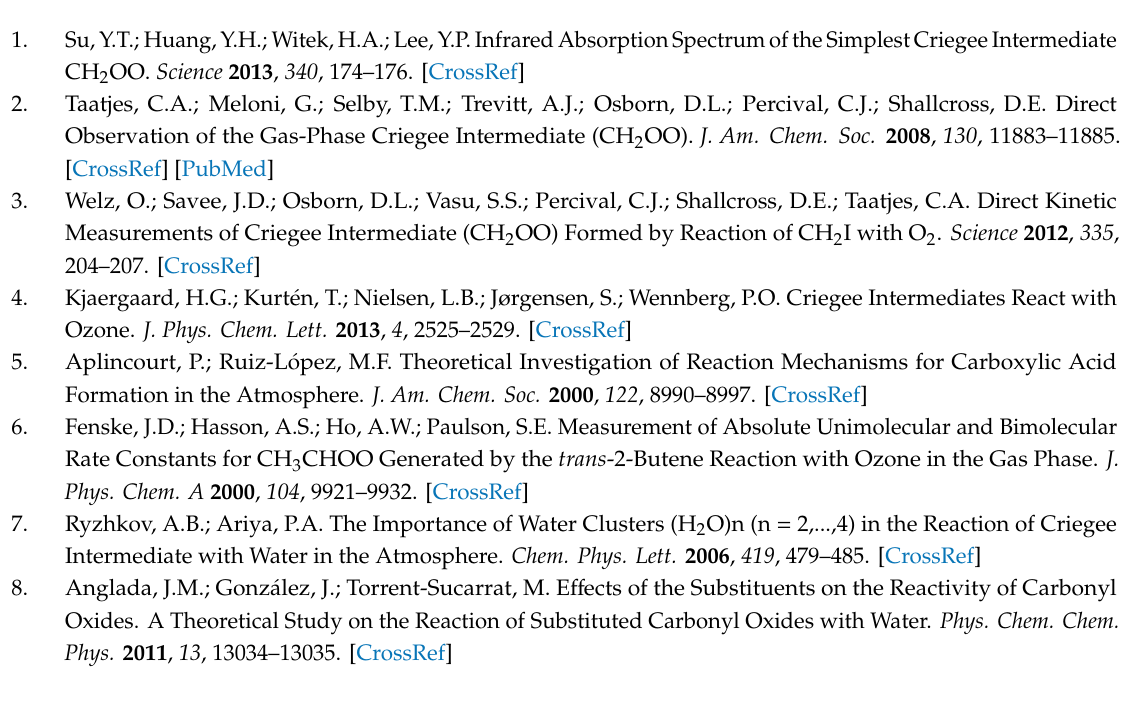
Supplementary Materials: Figure S1: Optimized geometries of species including reactants, reactant complexes, transition states and intermediates involved in the reaction of anti -PhCHOO + SO 2 at the UB3LYP / 6-311 ++ G(d,p) level. Figure S2: Optimized geometries of various species involved in the subsequent reaction pathways of IM1 at the UB3LYP / 6-311 ++ G(d,p) level. Figure S3: Optimized geometries of various species involved in the subsequent reaction pathways of IM2 at the UB3LYP / 6-311 ++ G(d,p) level. Figure S4: The intrinsic reaction coordinate of TSIM1-P3. Table S1: The total energies (hartree) obtained at the UCCSD(T) // UB3LYP and UCCSD // UB3LYP levels of theory together with the %TAE(T) of various species in the reaction of anti -PhCHOO + SO 2 . Table S2: The ZPE (hartree), total energies (E, hartree) and relative energies ( ∆ E, ∆ (E + ZPE), kJ / mol) without and with ZPE corrections of various species calculated at the UCCSD(T) // UB3LYP levels of theory in the reaction of anti -PhCHOO + SO 2 . Cartesian coordinates for all optimized structures at the UB3LYP / 6-311 ++ G(d,p) and UBH&HLYP / 6-311 ++ G(d,p) levels of